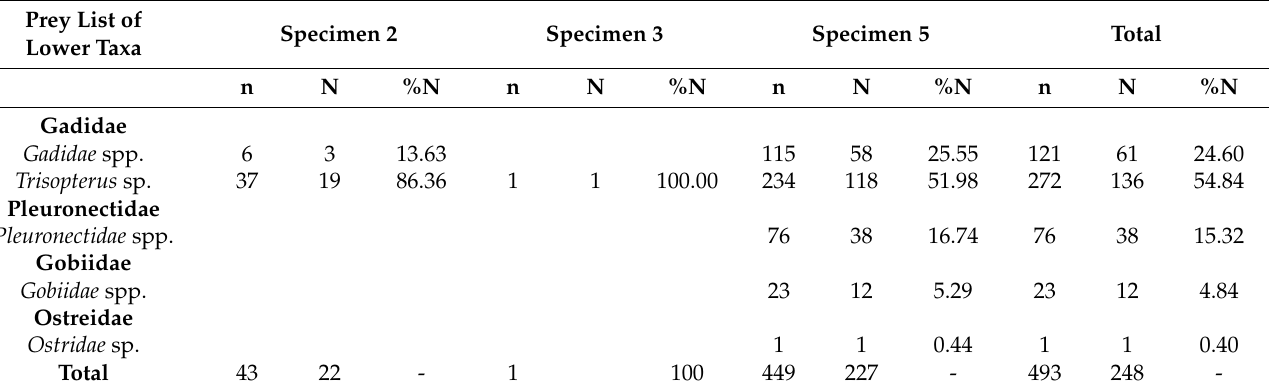
Table 3. Summary of the hard part analysis of the Sowerby’s beaked whales ( Mesoplodon bidens ) that died in Swedish waters 2015–2020 and had hard parts in the gastrointestinal tract. Due to erosion the otoliths could not be assessed to species level. n is number of otoliths; N is the minimum number of prey estimated from otolith count and %N is the numerical frequency of the number of prey in the